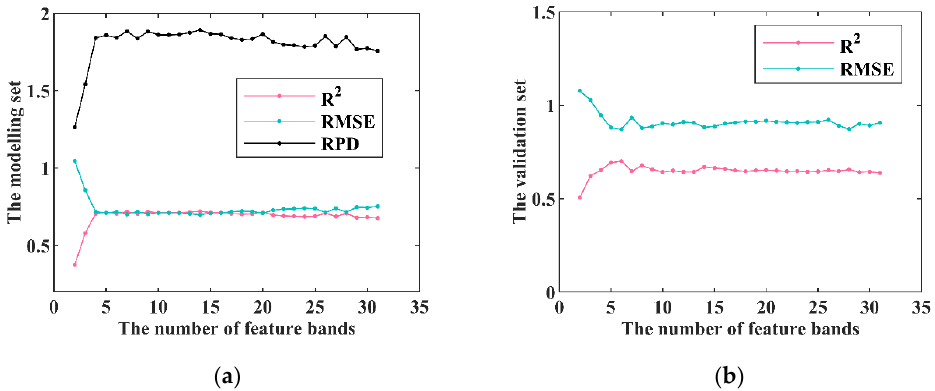
Figure 5. Model performance for ( a ) the modelling set and ( b ) the validation set with different sensitive bands.